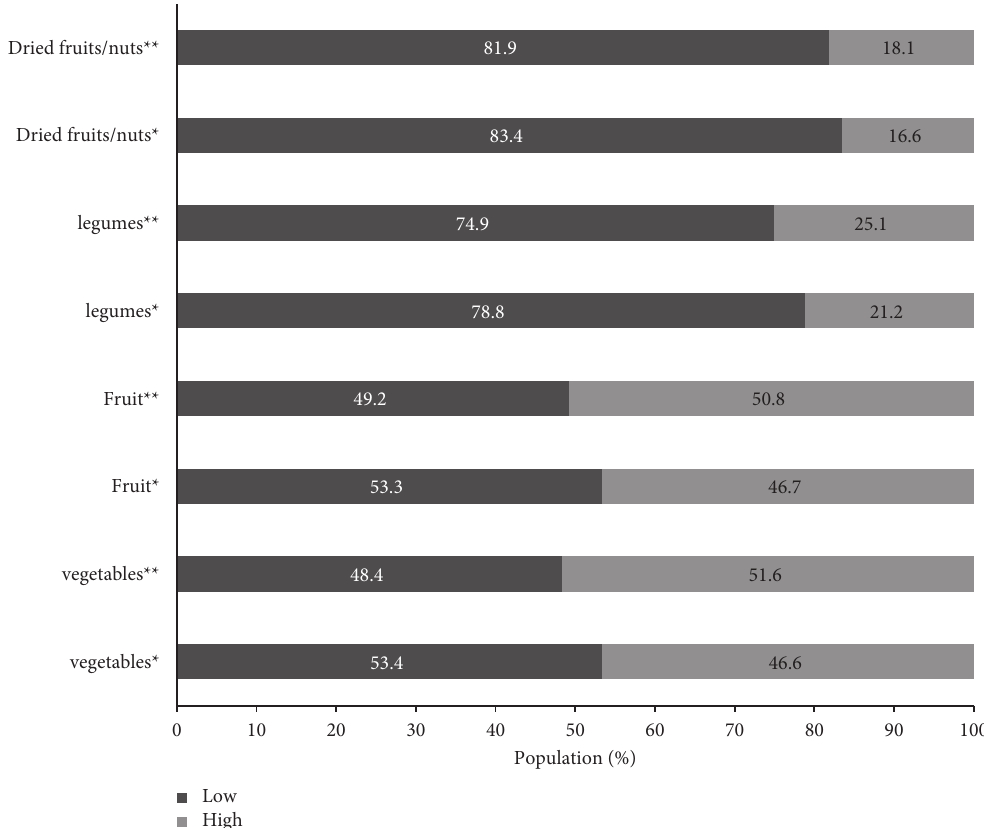
Figure 2: Changes in the frequency of low and high consumption of plant-based foods before and during social isolation. ∗ Before social isolation; ∗∗ during social isolation.